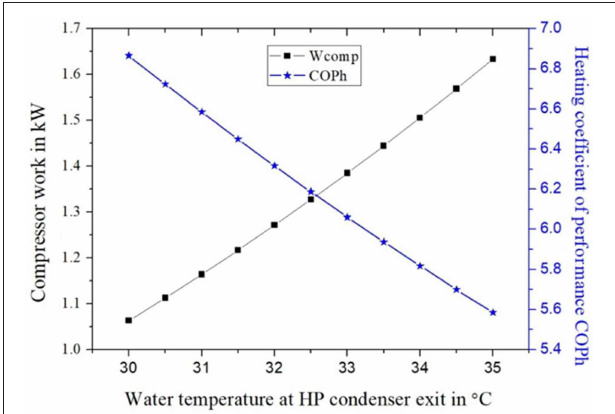
FIGURE 3 | HP compressor work and COP h under variable T w − exit − HP .